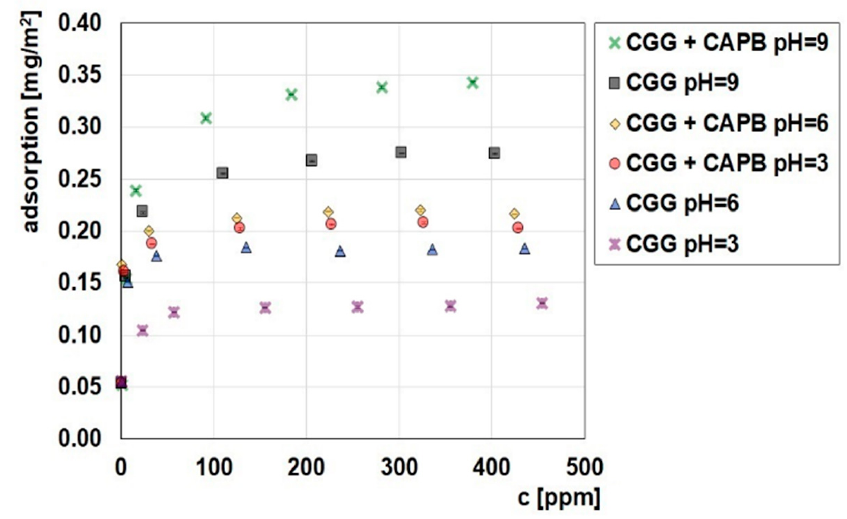
Figure 6. Influence of CAPG (0.04%) on the CGG adsorption on the glauconite surface at different pH values.